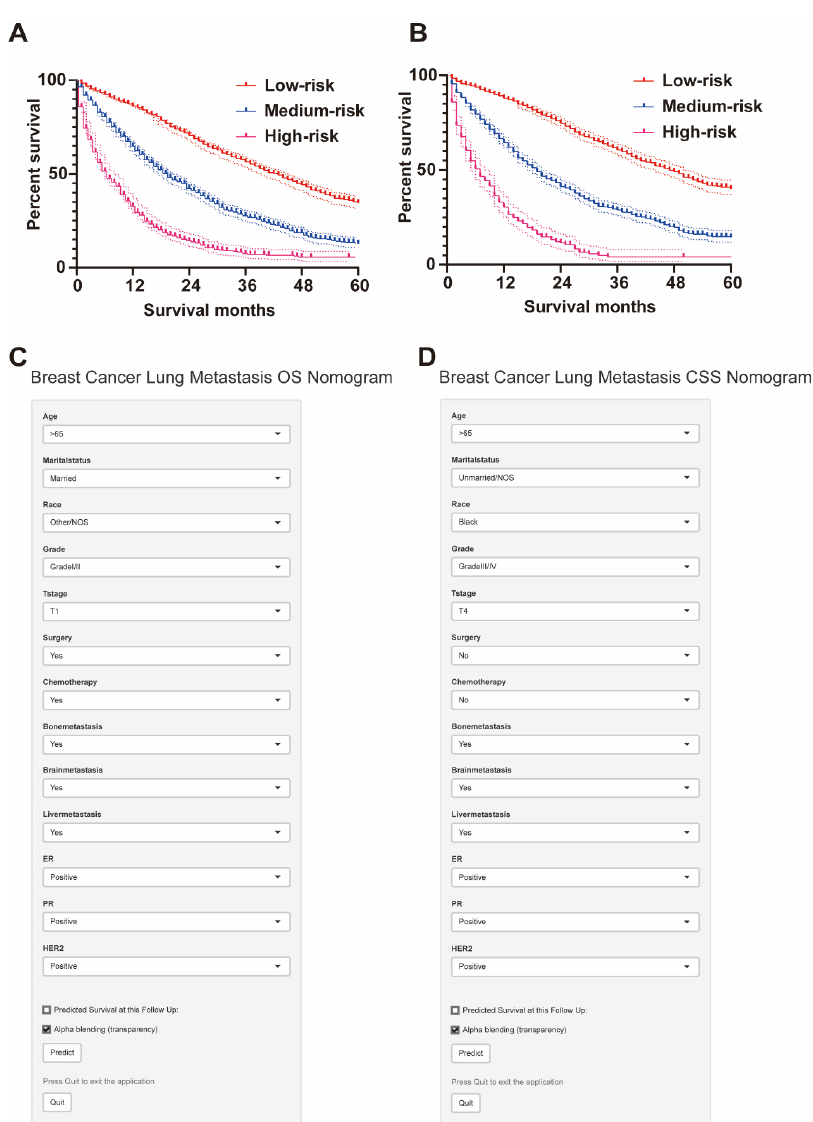
Figure 5. Risk stratification by the total score for subgroup survival analysis and web-based dynamic nomogram. ( A ) The 5-year OS rate is the highest in the low-risk group at 34.5%, followed by the intermediate-risk group at 12.9%, and the worst at 4.9% in the high-risk group. ( B ) The low-risk group had the highest 5-year CSS rate at 40.1%, followed by the intermediate-risk group with 14.5%, and the high-risk group with 4.6%. ( C ) Web-based dynamic nomogram of OS of BCLM patients (https: //nomogram-xiangyahospital.shinyapps.io/BCLMOSnomogram) (accessed on 20 December 2022). ( D ) Web-based dynamic nomogram of CSS of BCLM patients (https://cssnomogram-xiangyahospital. shinyapps.io/DynNomapp) (accessed on 20 December